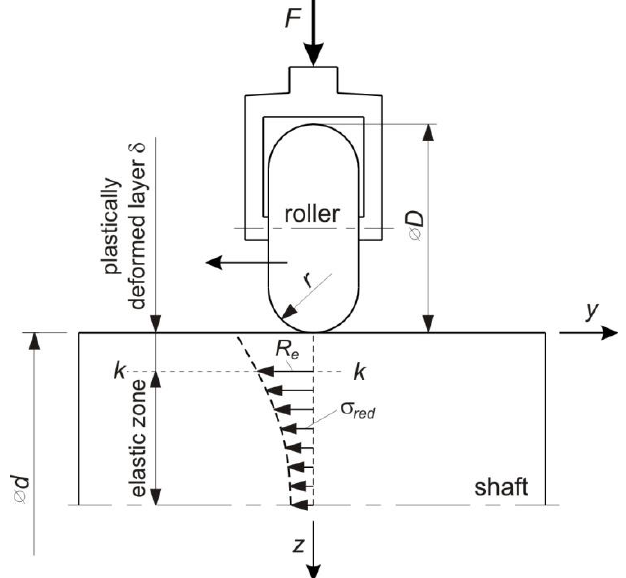
Figure 1. The roller burnishing scheme used to calculate the thickness of the plastically deformed surface layer along the axis of action of the thrust force (at x = y = 0): D – roller diameter, r – roller radius, d – shaft diameter, δ – depth of plastic deformation, R e – yield stress. The distribution of elastic stresses during burnishing is presented as a dashed line.